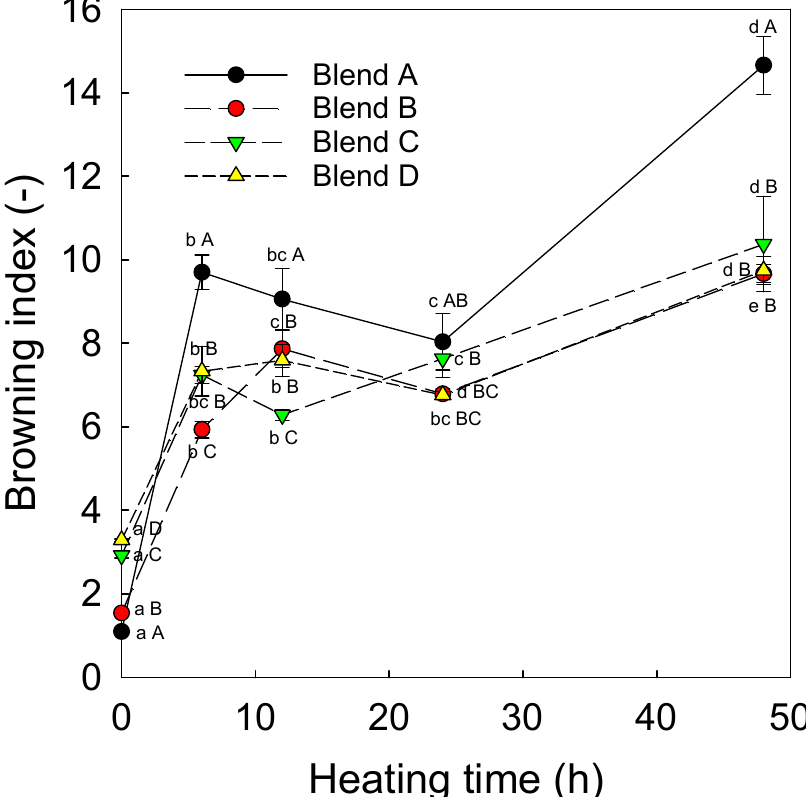
Figure 4. Browning index (mean ± standard deviation) versus the heating time for the different ratios (A (80:10:5), B (80:10:10), C (80:10:15), and D (80:10:20)) of the fibers (the different letters indicate significant differences ( p < 0.05) between the heating times of each blend (lowercase) and between blends at the same heating time (upper case)).